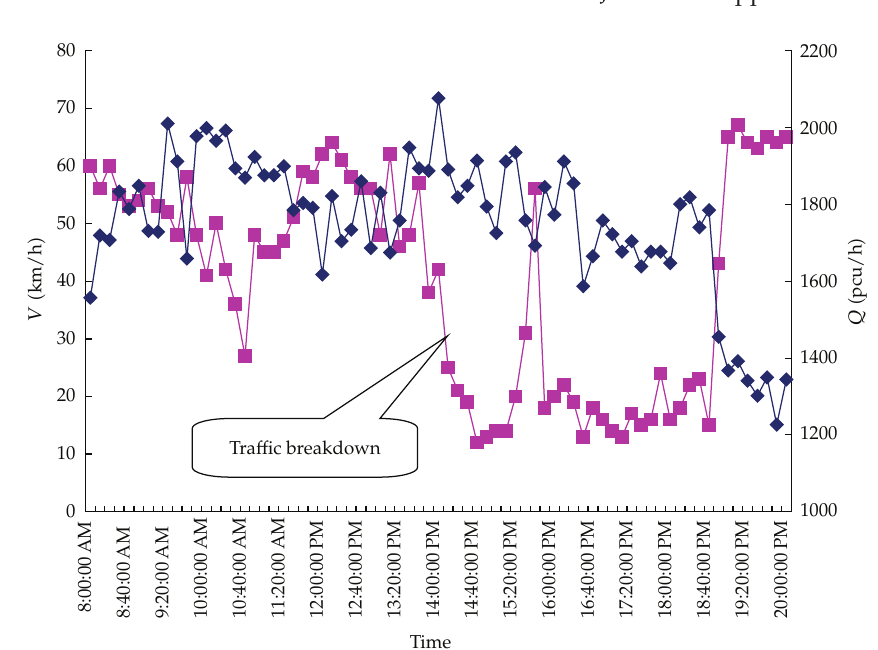
Figure 1: Time serial of tra ffi c flow rates and speed.